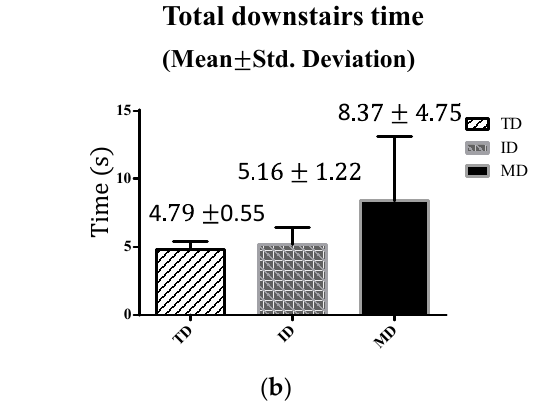
Figure 10. Downstairs walking results: ( a ) average down-one-stair time; and ( b ) total downstairs time.